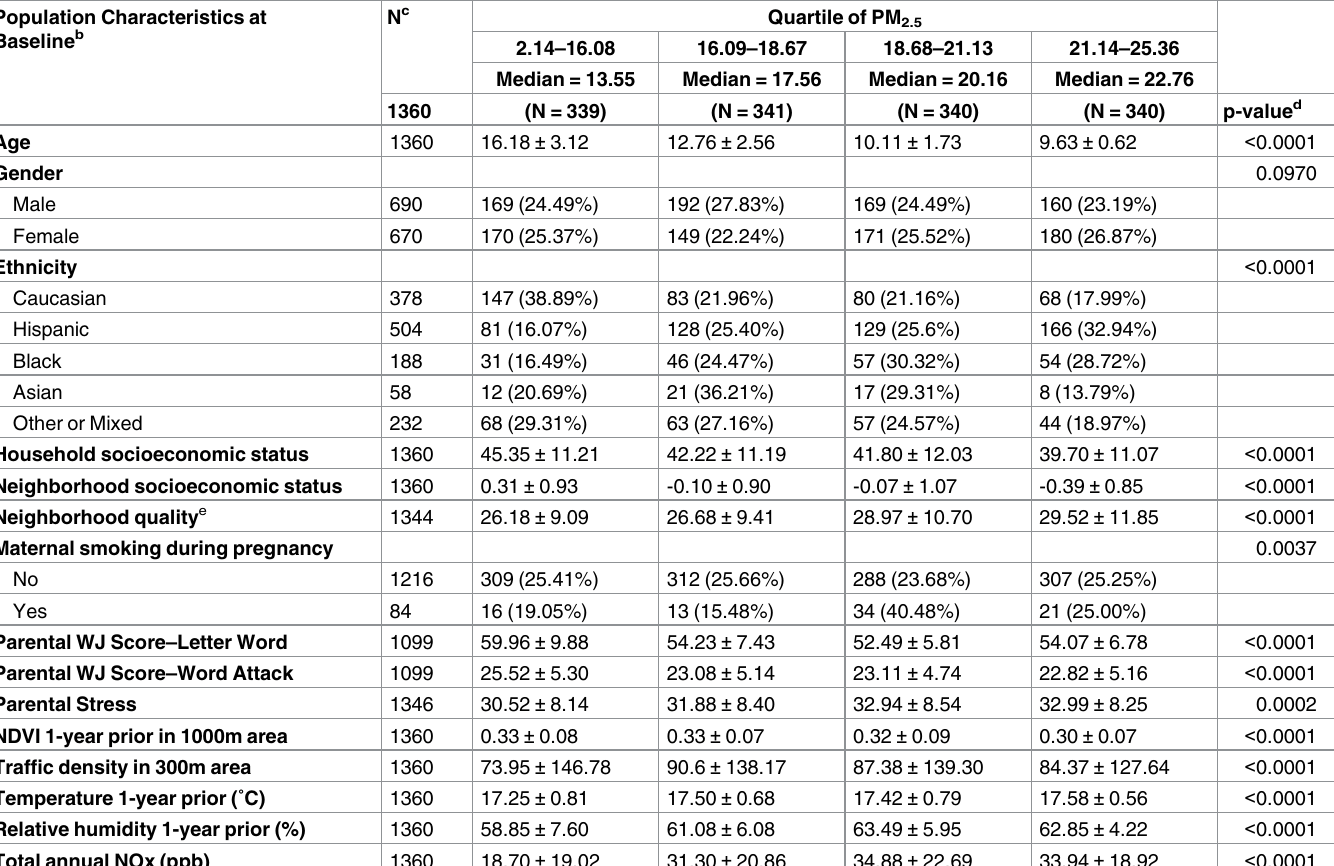
Table 1. Population characteristics in relation to the overall a PM 2.5 exposure 1-yearprior to IQ assessment. Population Characteristics at Baseline